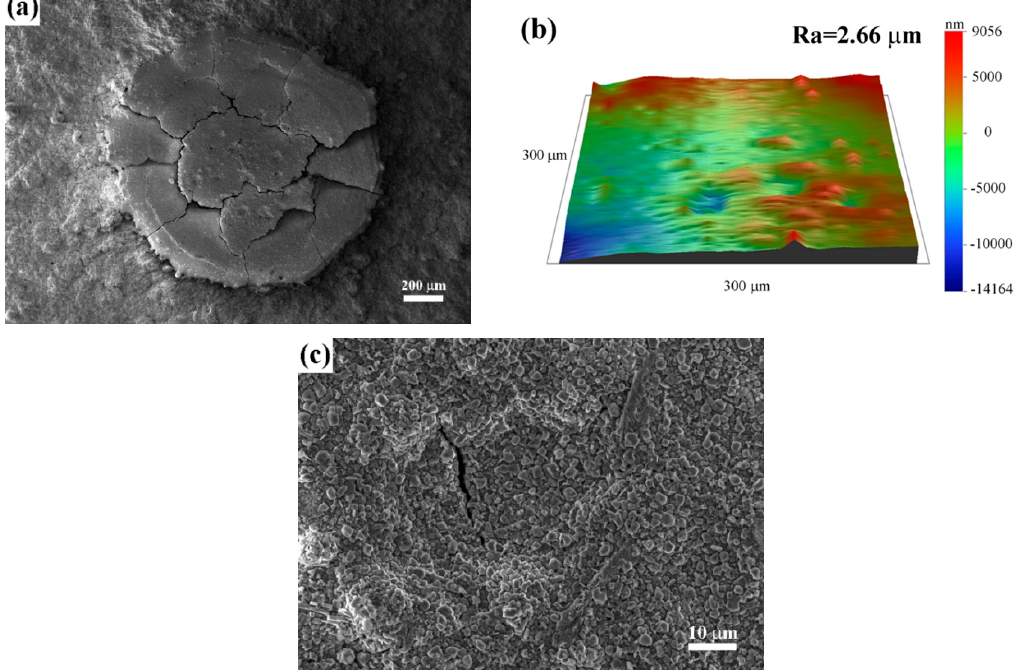
Figure 6. ( a ) Surface morphology, ( b ) surface roughness, and ( c ) high magnification surface micrograph of the dotted unit in the Al deposition (DA) specimen.